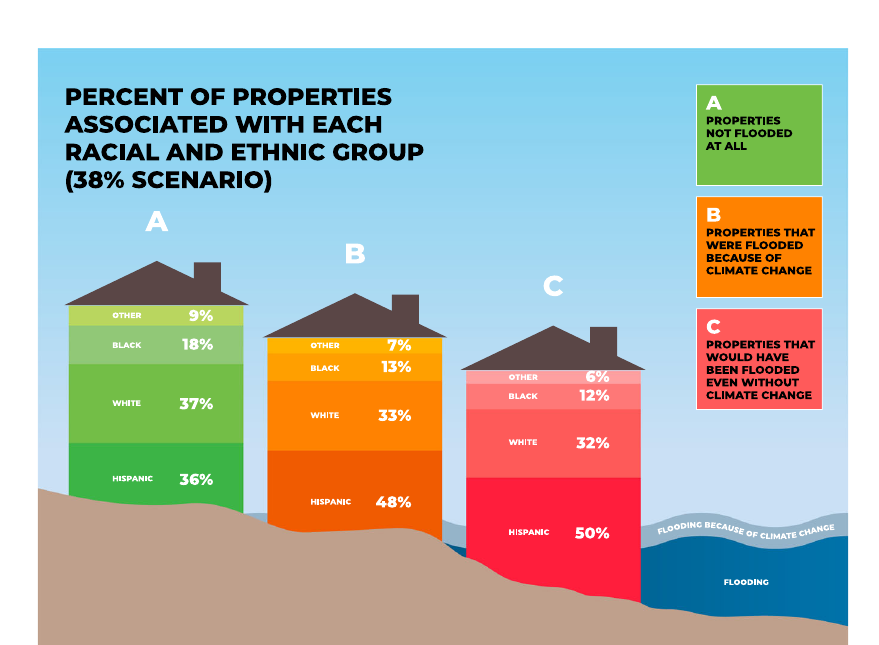
Fig. 2 Percent of properties associated with each racial and ethnic group (38% scenario). Estimated percentages for residential properties in Harris County, Texas during Hurricane Harvey. Note: Group A included 1,002,026 parcels, group B 53,616 parcels, and group C 52,439